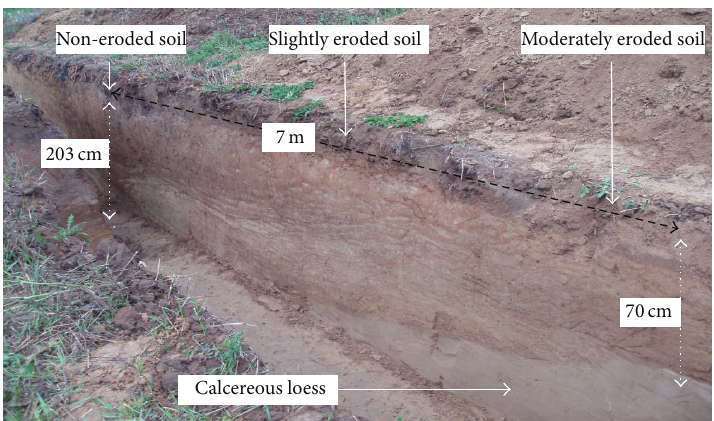
Figure 9: Changes in the depth of soil in transect at the distance of 66–70 m (part of the stand 4) (Photo J.